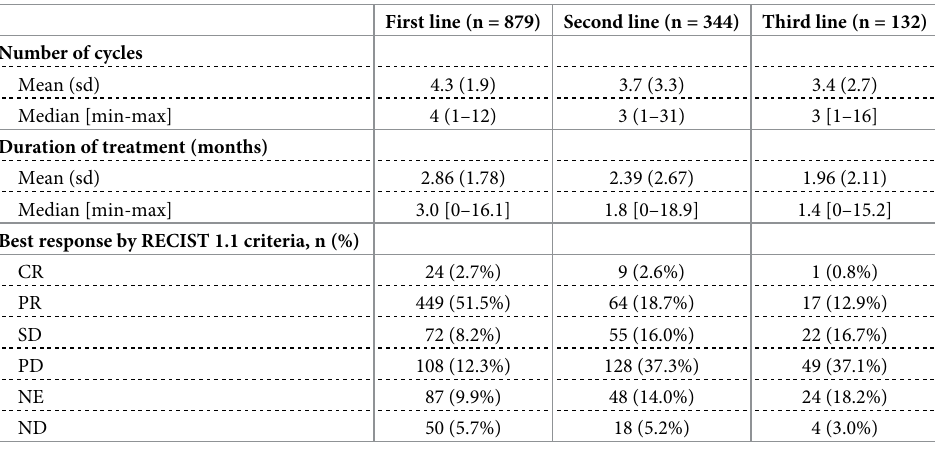
Table 3. Chemotherapy treatment and